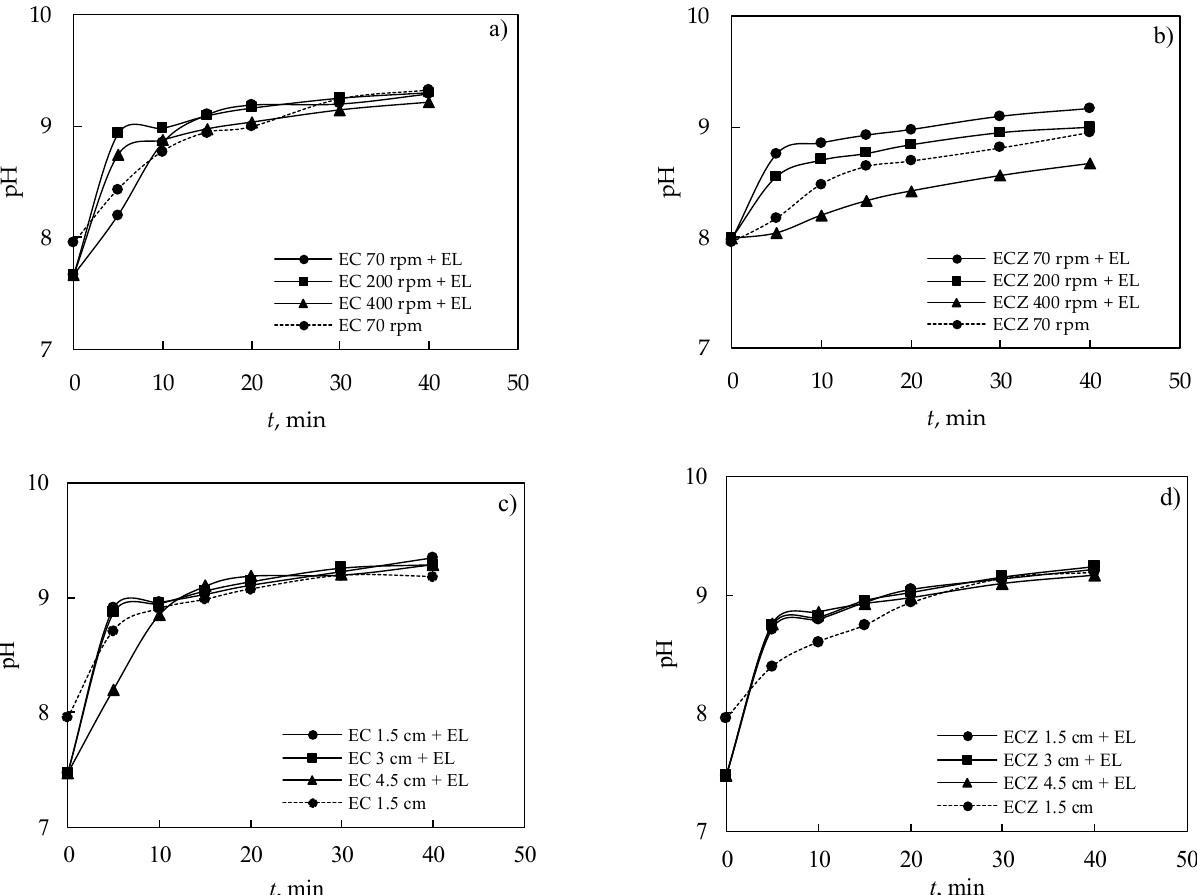
Figure 1. Change of pH values in solution during EC process at different: ( a ) stirring speed; ( b ) stirring speed with the addition of zeolite; ( c ) electrode distance; ( d ) electrode distance with addition of zeolite. Note: mark EL means the addition of electrolyte.